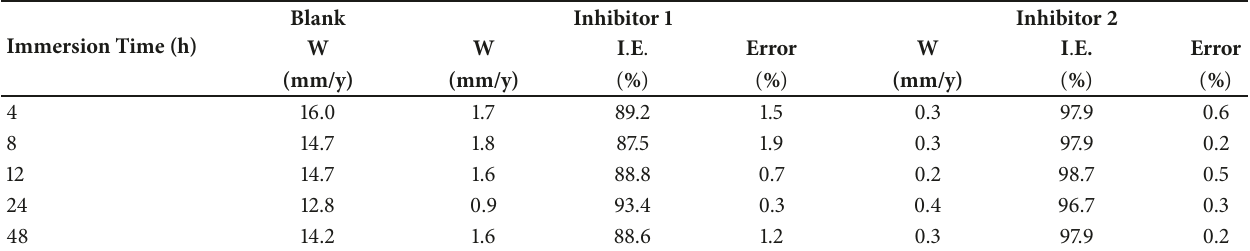
Table 3: Inhibitor efficienciesand corrosion rates to carbon steel in 1.0 mol L – 1 HCl aqueous solution in presence and absence of the inhibitor (500mg L −1 ) with different immersion times, at 25 ∘ C.